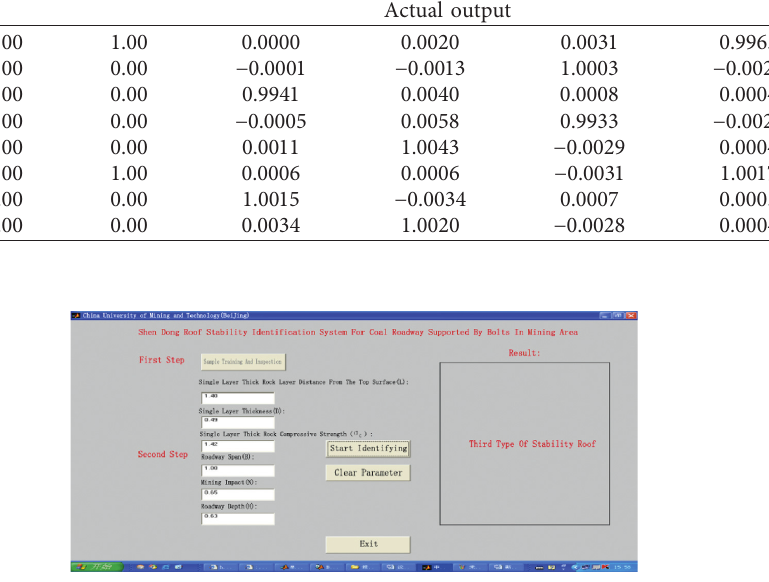
Figure 3: Identifying system classification of stability. Table 6: The output of network and its equal line.